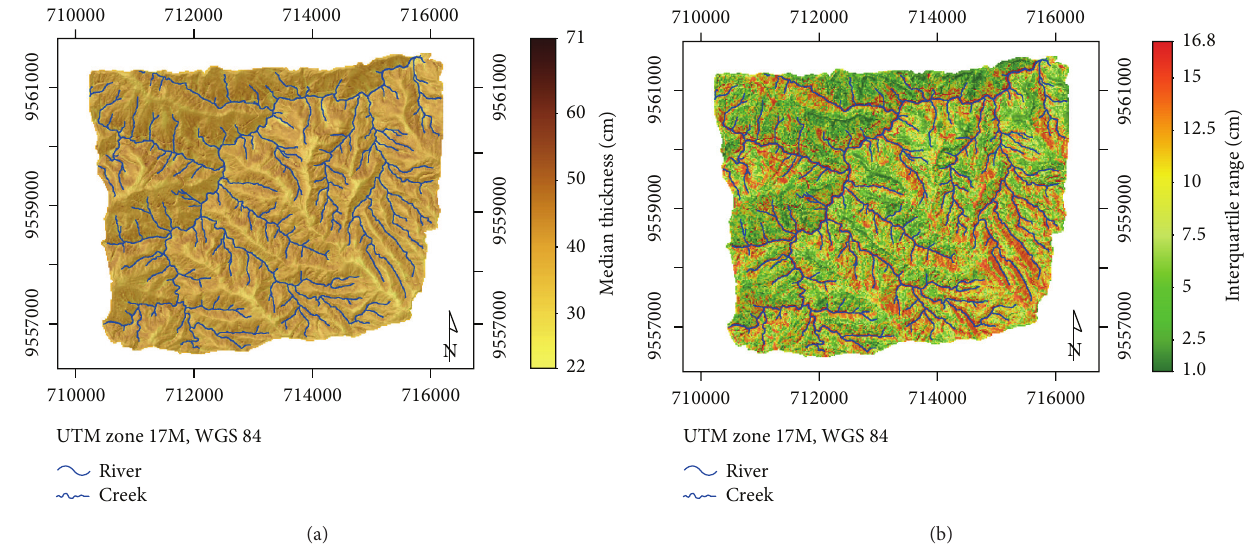
Figure 8: Median organic layer thickness (a) and interquartile range (b) (overlaid hillshading from north). < 6 cm (Figure 9(b)). The vertical development of the soil profile is less influenced by surface processes. According to Park and Vlek [53], soil attributes whose vertical distribution is strongly determined by vertical pedogenesis or unknown factors are poorly modelled by environmental